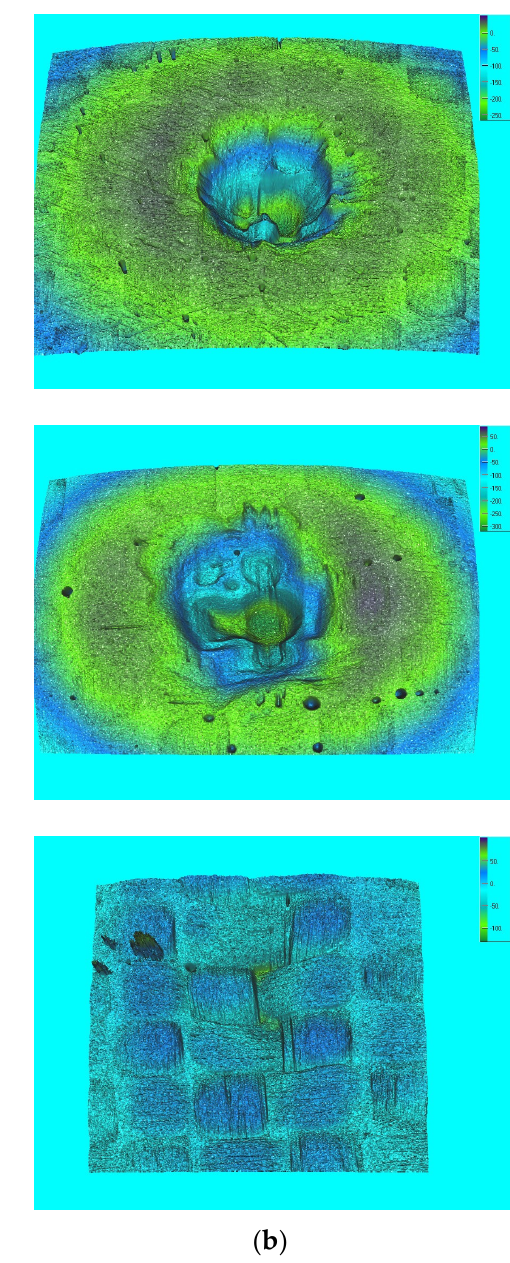
Figure 9. Eroded surface view for 10k samples: ( a ) microscopic view and ( b ) 3D surface pro- Figure filometer image.